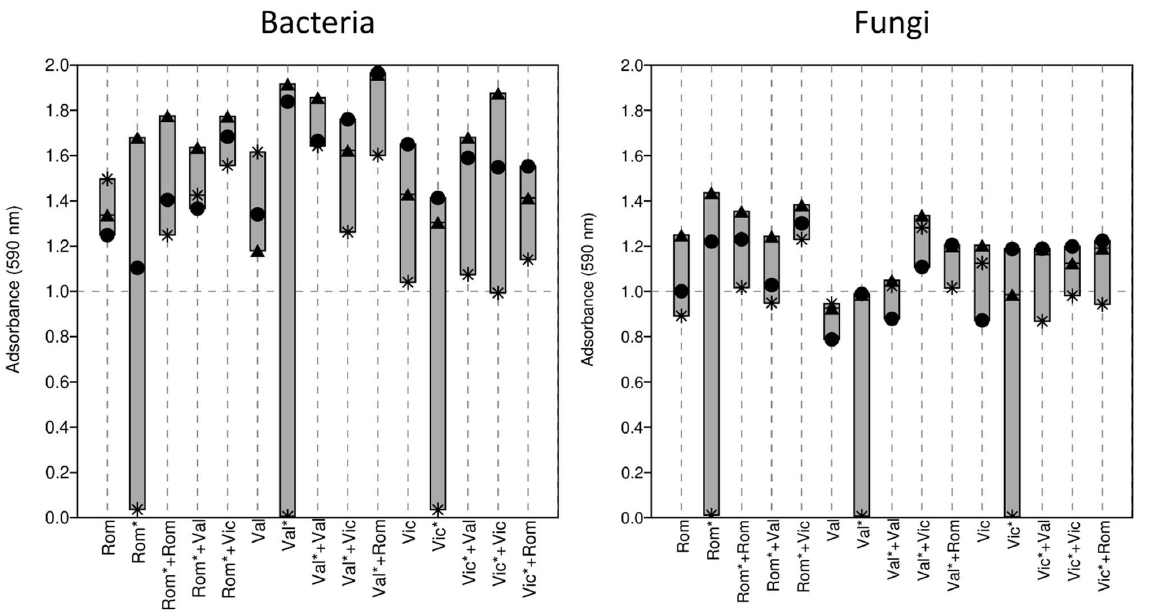
Figure 2. Biolog average well color development (AWCD) values for bacteria (EcoPlates) and fungi (FF microplates) from self- or cross-reinoculated heat-sterilized Romola, Vallombrosa and Vicarello soils after 1 day (star), 7 days (triangle) and 30 days of incubation (circle).